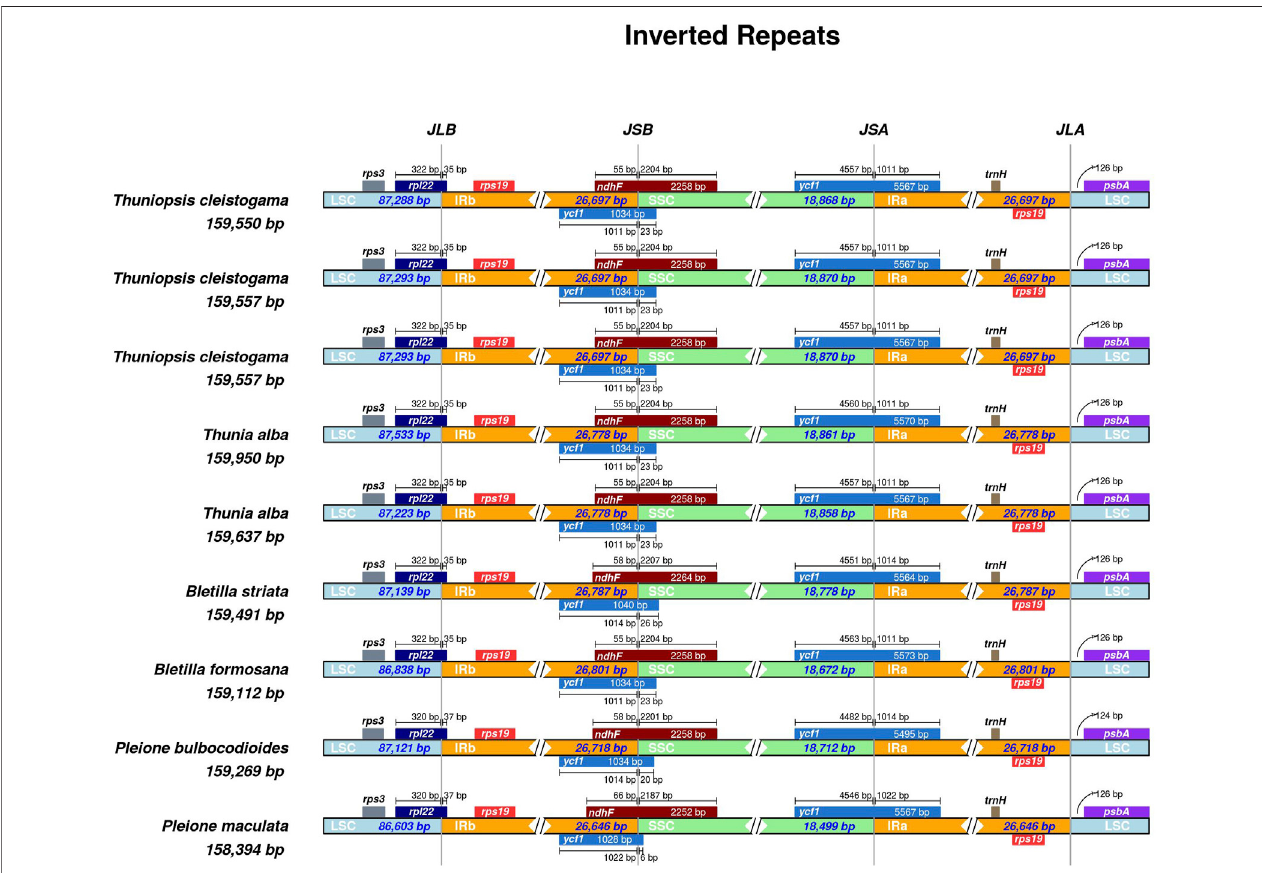
FIGURE 6 | Comparison of the borders of large single-copy (LSC), small single-copy (SSC), and inverted repeat (IR) regions among the nine cp genomes. The numbers above the gene features denote the distance between the gene borders, either the start or end of genes and the junction sites.